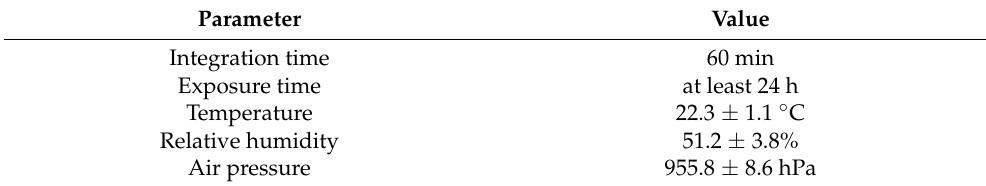
Table 2. Technical parameters of the intercomparison. Parameter